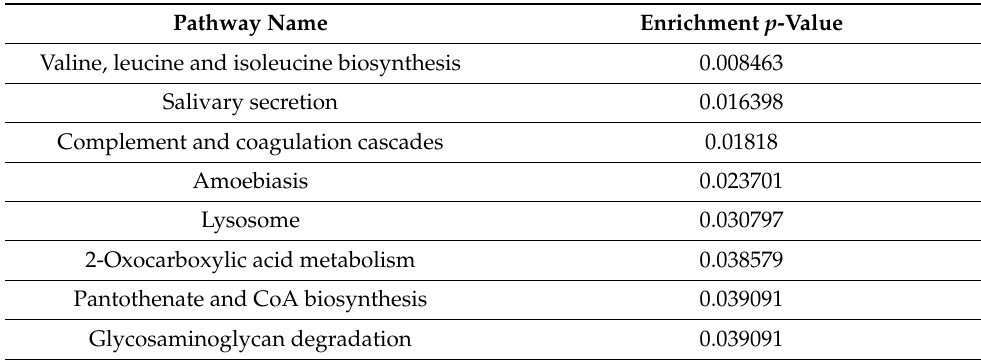
Table 1. The predicted pathway of more abundant salivary protein in Streptococcus pneumoniae group than Influenza A group.